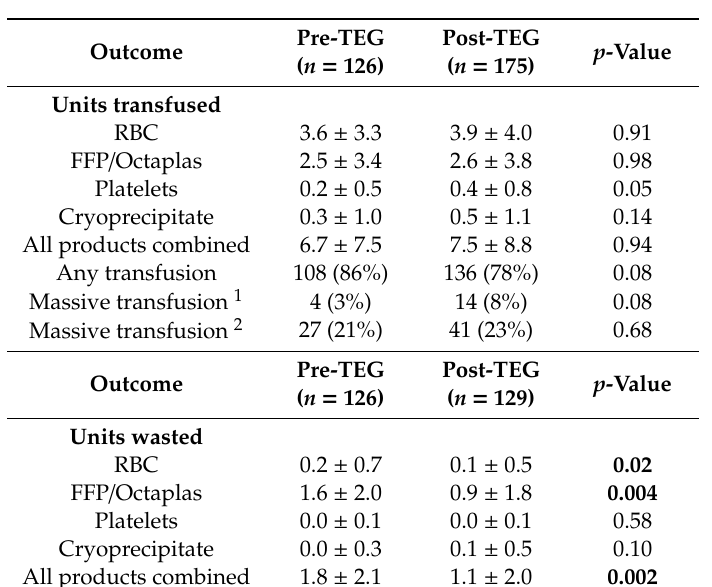
Table 3. Blood product